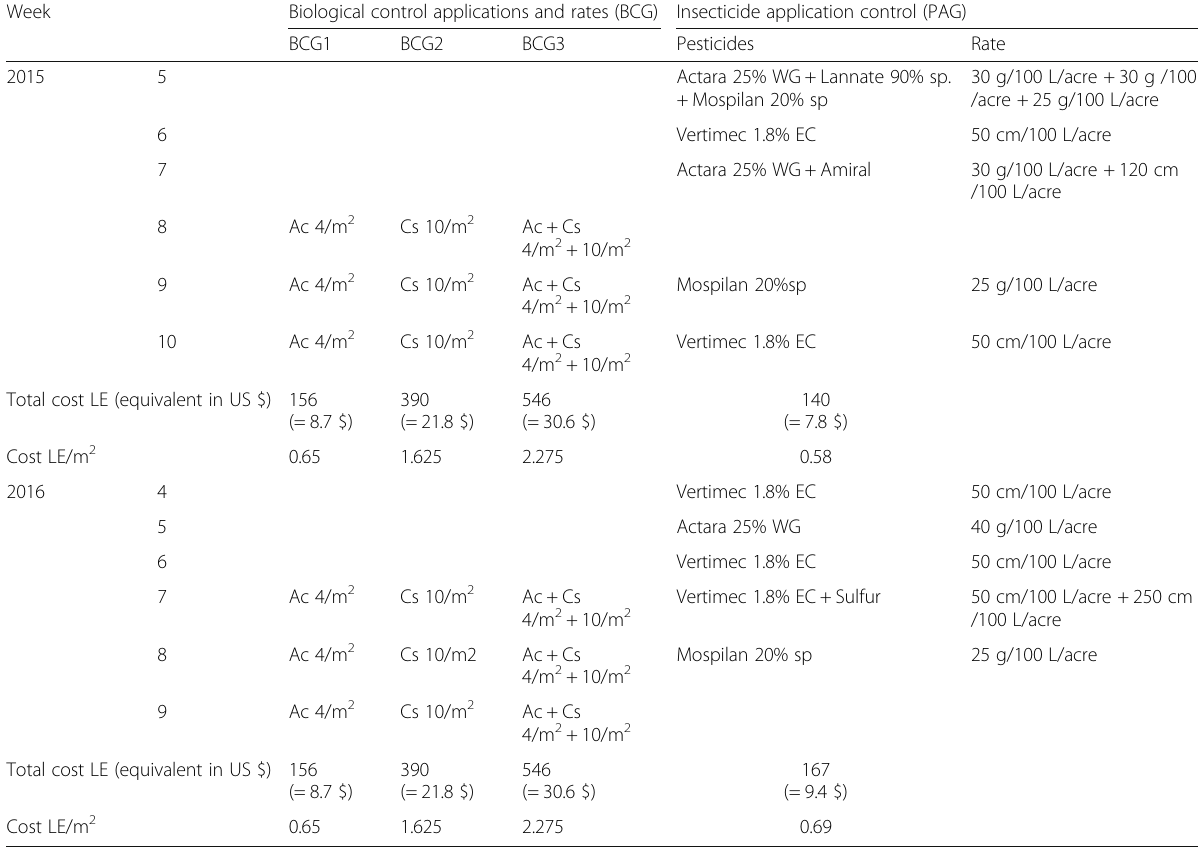
Table 1 Rates of releases of biological control agents and insecticides applications, costs of control treatments in cucumber greenhouses in summer plantation, 2015 – 2016